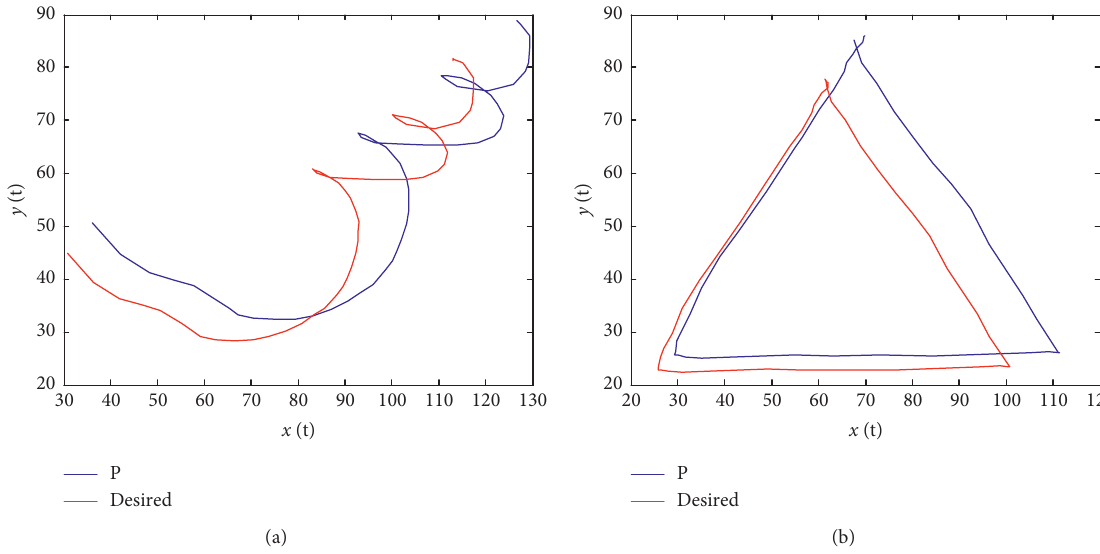
Figure 10: Simulation results for the P controller applied to (a) Arabic letter ‘SIN’ and (b) triangle.